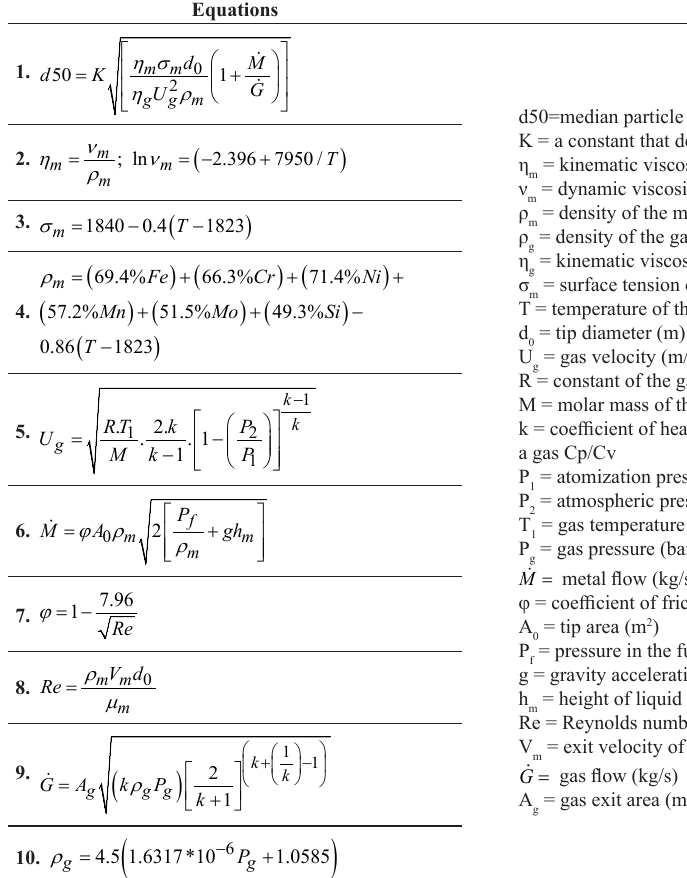
Table 1. Proposed mathematical model (set of equations) used to calculate the median particle size d50 based on Lubanska equation. Equations